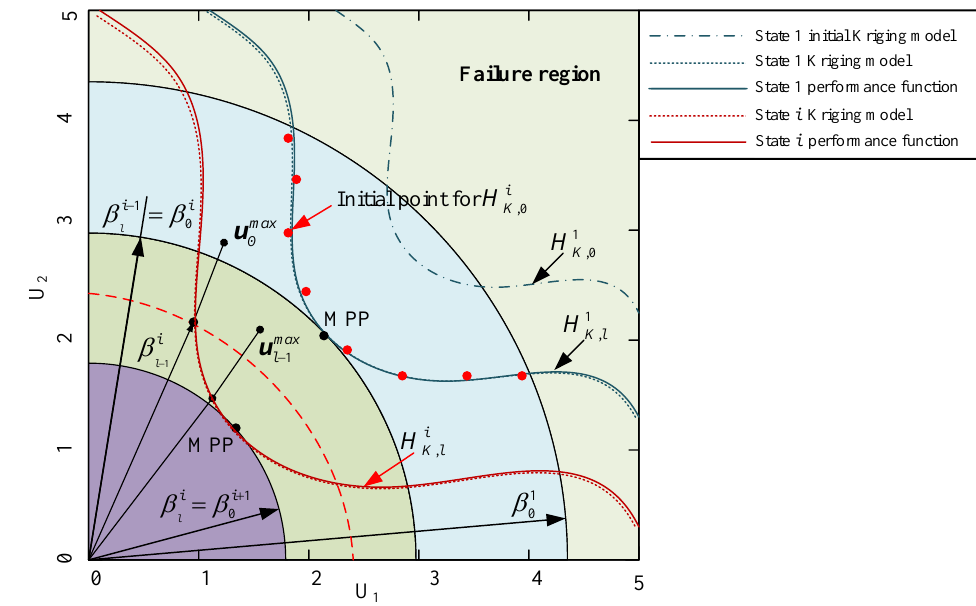
Figure 10. Schematic diagram of Kriging model in different degenerate